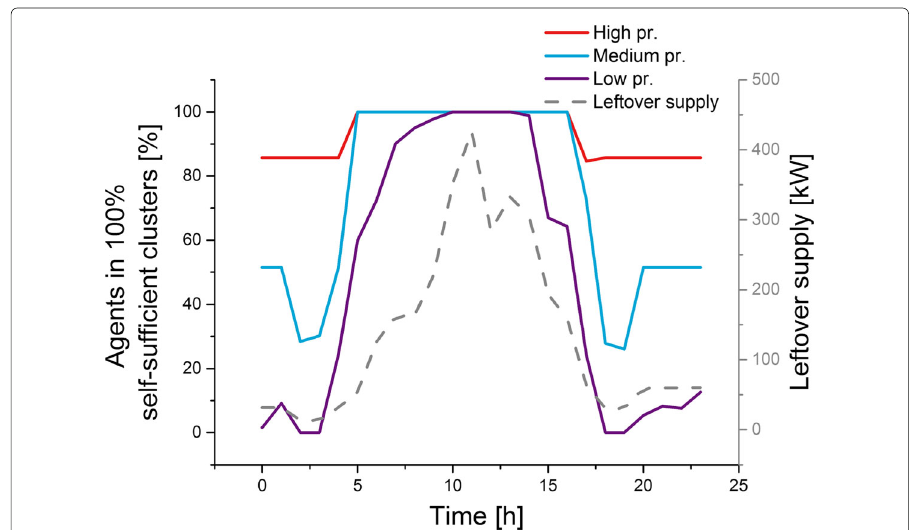
Fig. 10 Percentage of non-self-sufficient agents of each priority that are in 100% self-sufficient clusters - Wind and solar